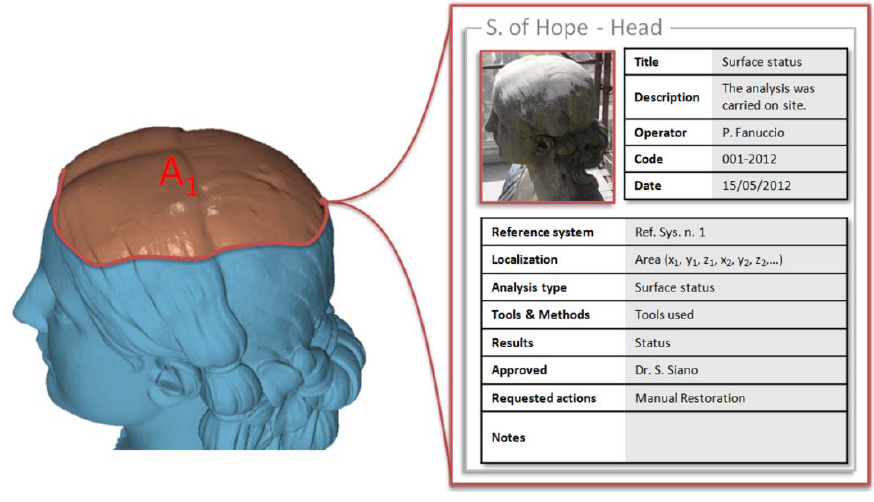
Figure 14. 3D referring of metadata to the corresponding area of interest A covering the head of the Statue of